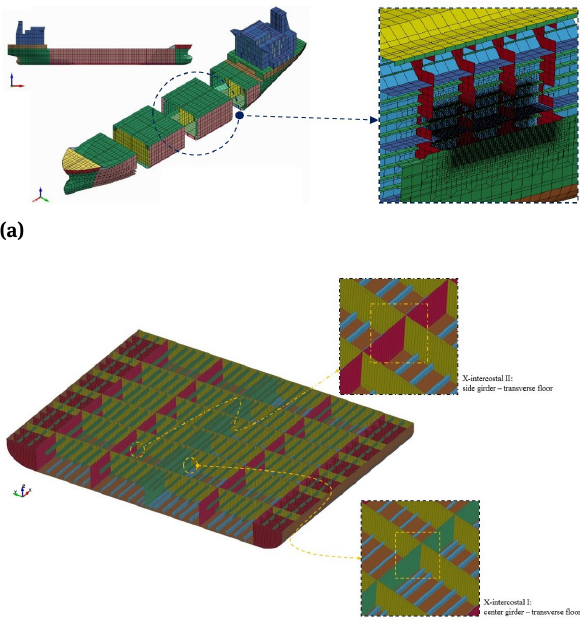
Figure 2: Examples of thin-walled geometries based on actual ship structure: (a) intersections of trans. webs and long. stiffener on the side hull [12], and (b) floor-girder intersection on the bottom structures